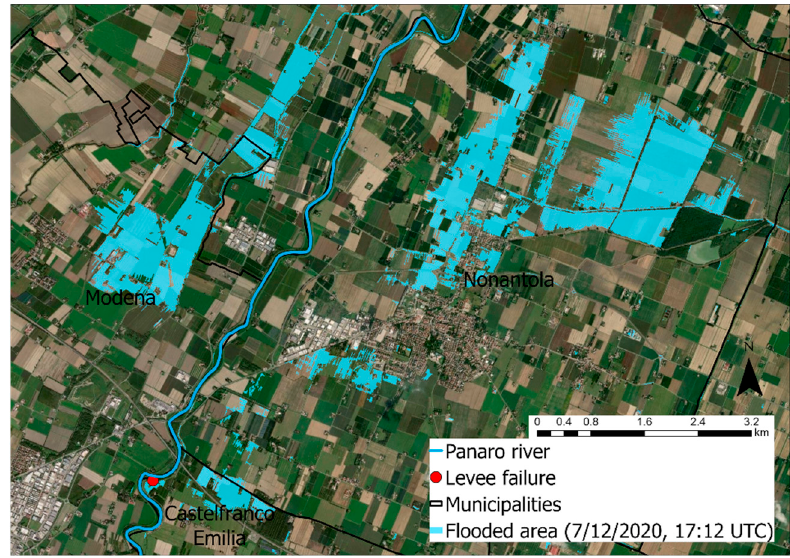
Figure 5. Flooded area on the day after the event (from Copernicus EMS).